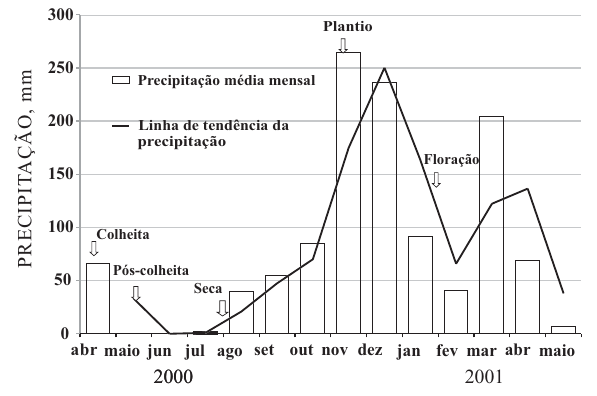
Figura 1. Distribuição de chuvas no período experimental (abril/2000 a maio/2001) e épocas de